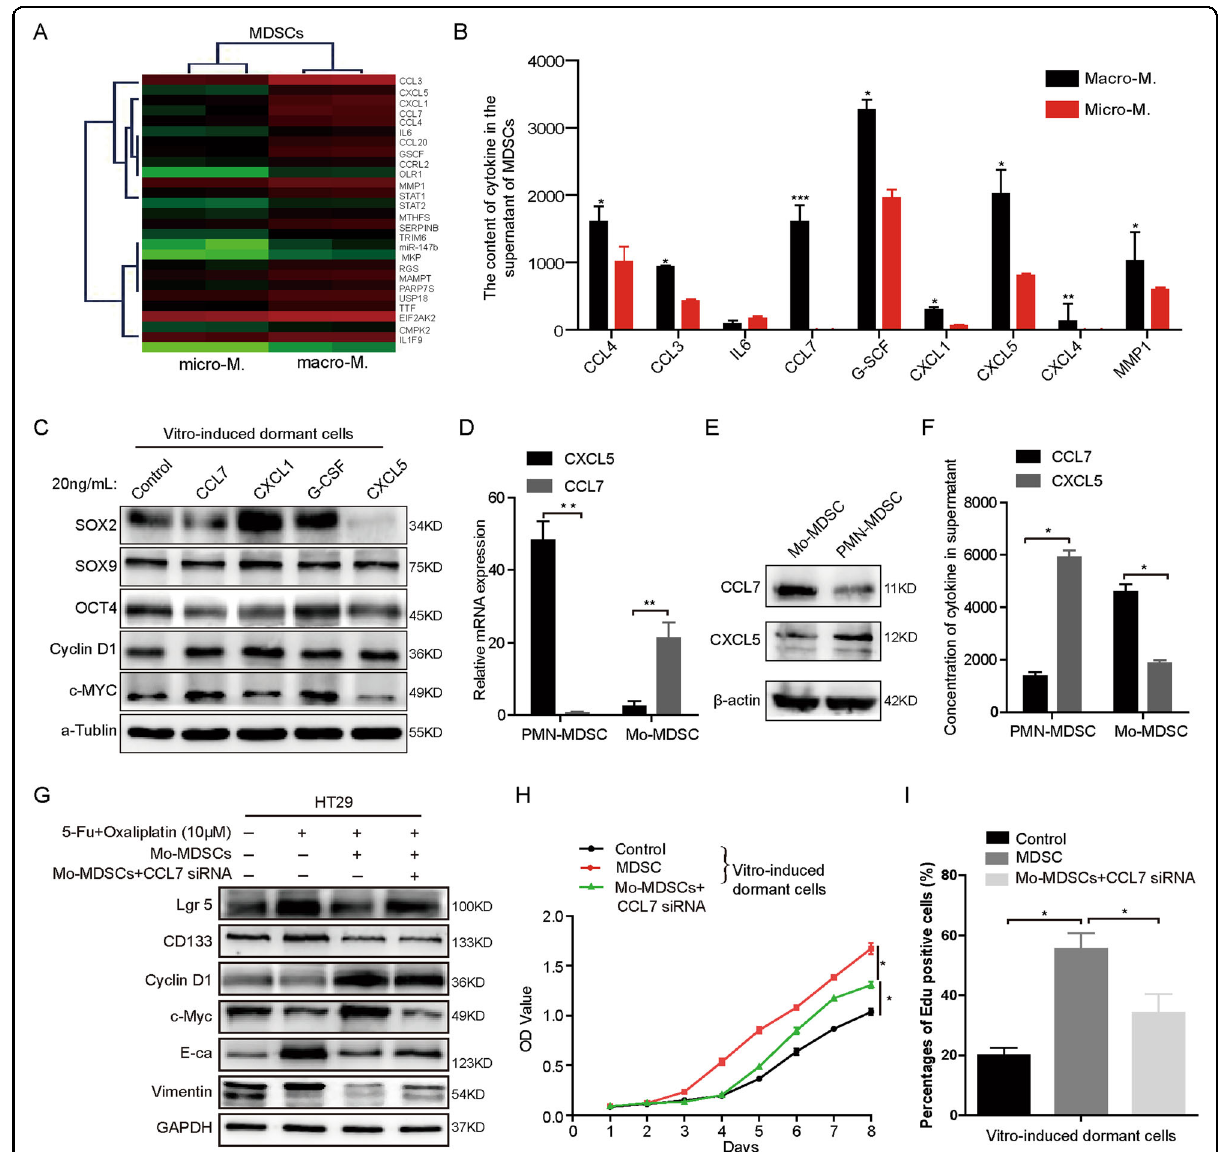
Fig. 4 CCL7 secreted by Mo-MDSCs is required for dormant cell activation. A Gene array analyses of the MDSCs in micro-metastases and macro- metastases. B Cytokines in the cultural supernatant of mice macro-metastases and micro-metastases MDSCs were detected by Elisa assays. C The protein levels of c-Myc, Cyclin D1, OCT4, SOX9, and SOX2 in vitro-induced-dormant cells stimulated with CXCL5, CCL7, G-CSF, CXCL5, and CXCL1 (20 ng/mL) detected by western blotting. D , E The mRNA and protein of CCL7 in Mo-MDSCs and PMN-MDSCs were detected by Q-PCR and western blotting. F The contents of CCL7 in the cultural supernatant of Mo-MDSCs or PMN-MDSCs detected by Elisa assays respectively. G The protein levels of vimentin, E-ca, Cyclin D1, c-Myc, CD133, and Lgr5 in vitro-induced-dormant cells co-cultured with Mo-MDSCs or Mo-MDSCs siRNA. H Effect of vitro-induced-dormant cells co-cultured with Mo-MDSCs or Mo-MDSCs siRNA on cell proliferation detected by CCK-8 assay. I Effect of vitro-induced- dormant cells co-cultured with Mo-MDSCs or Mo-MDSCs siRNA detected by EdU assay. Error bars represent mean ± SD from at least three independent experiments. ** P < 0.01, * P <